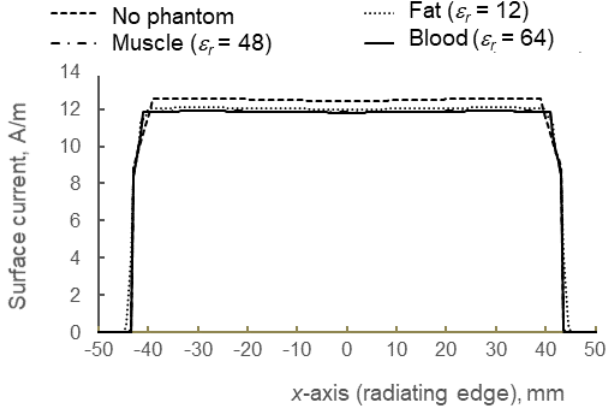
Figure 16. Magnetic surface currents along the x -axis (radiating edge). As the values of surface currents are similar for all cases, this factor can be omitted. It can be observed that when surface current is constant, high E-field intensity (V / m) for higher ε r and σ case is mainly due to the increase in Z in in lossy medium.